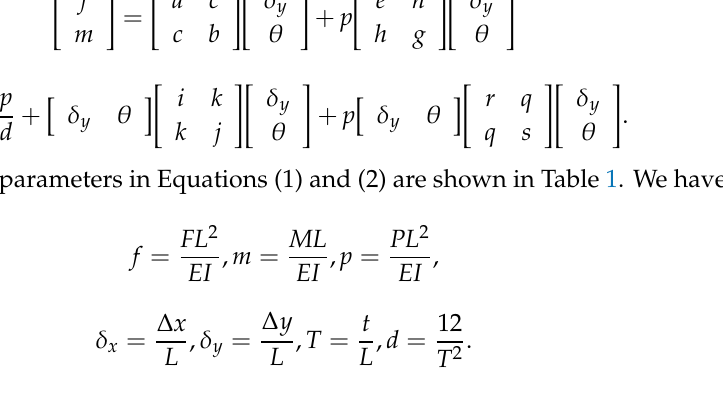
Table 1. Calculation parameters of beam constraint model. Parameters Values